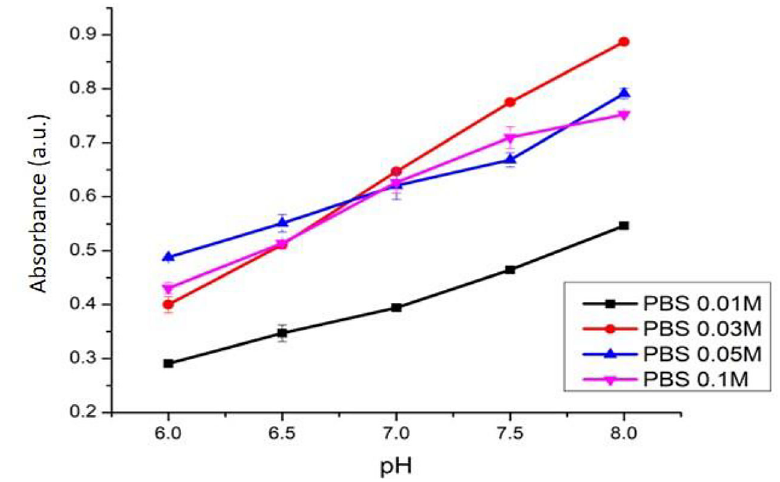
Figure 11. Effect of phosphate buffer concentration towards pH sensor ’ s